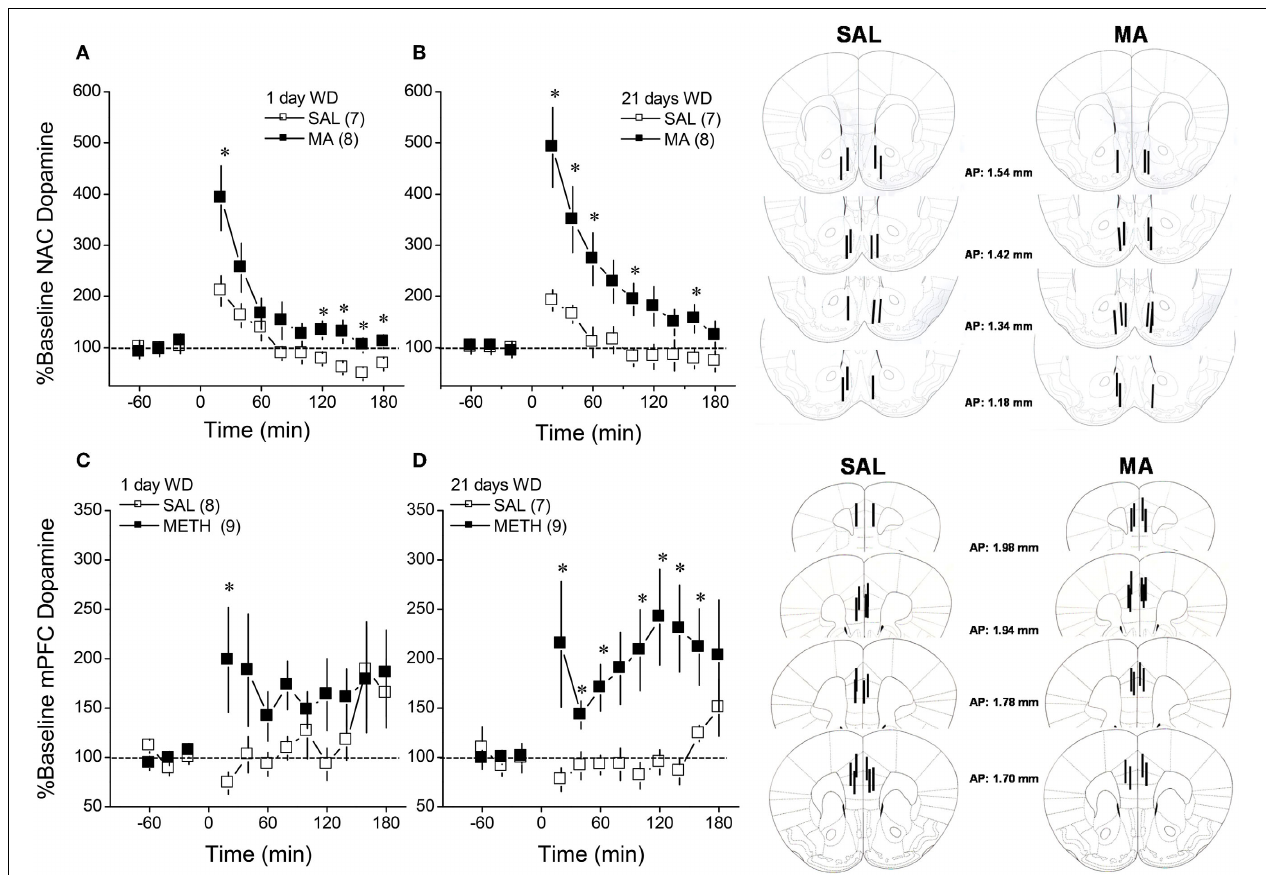
FIGURE 1 | Summary of the dopamine response to an i.p. challenge injection of 2mg/kg methamphetamine (MA), administered at either 1 day (left) or 21 days (right) withdrawal (WD), exhibited by B6 mice with a 10-day history of repeated MA (2mg/kg) or saline (SAL). When measured